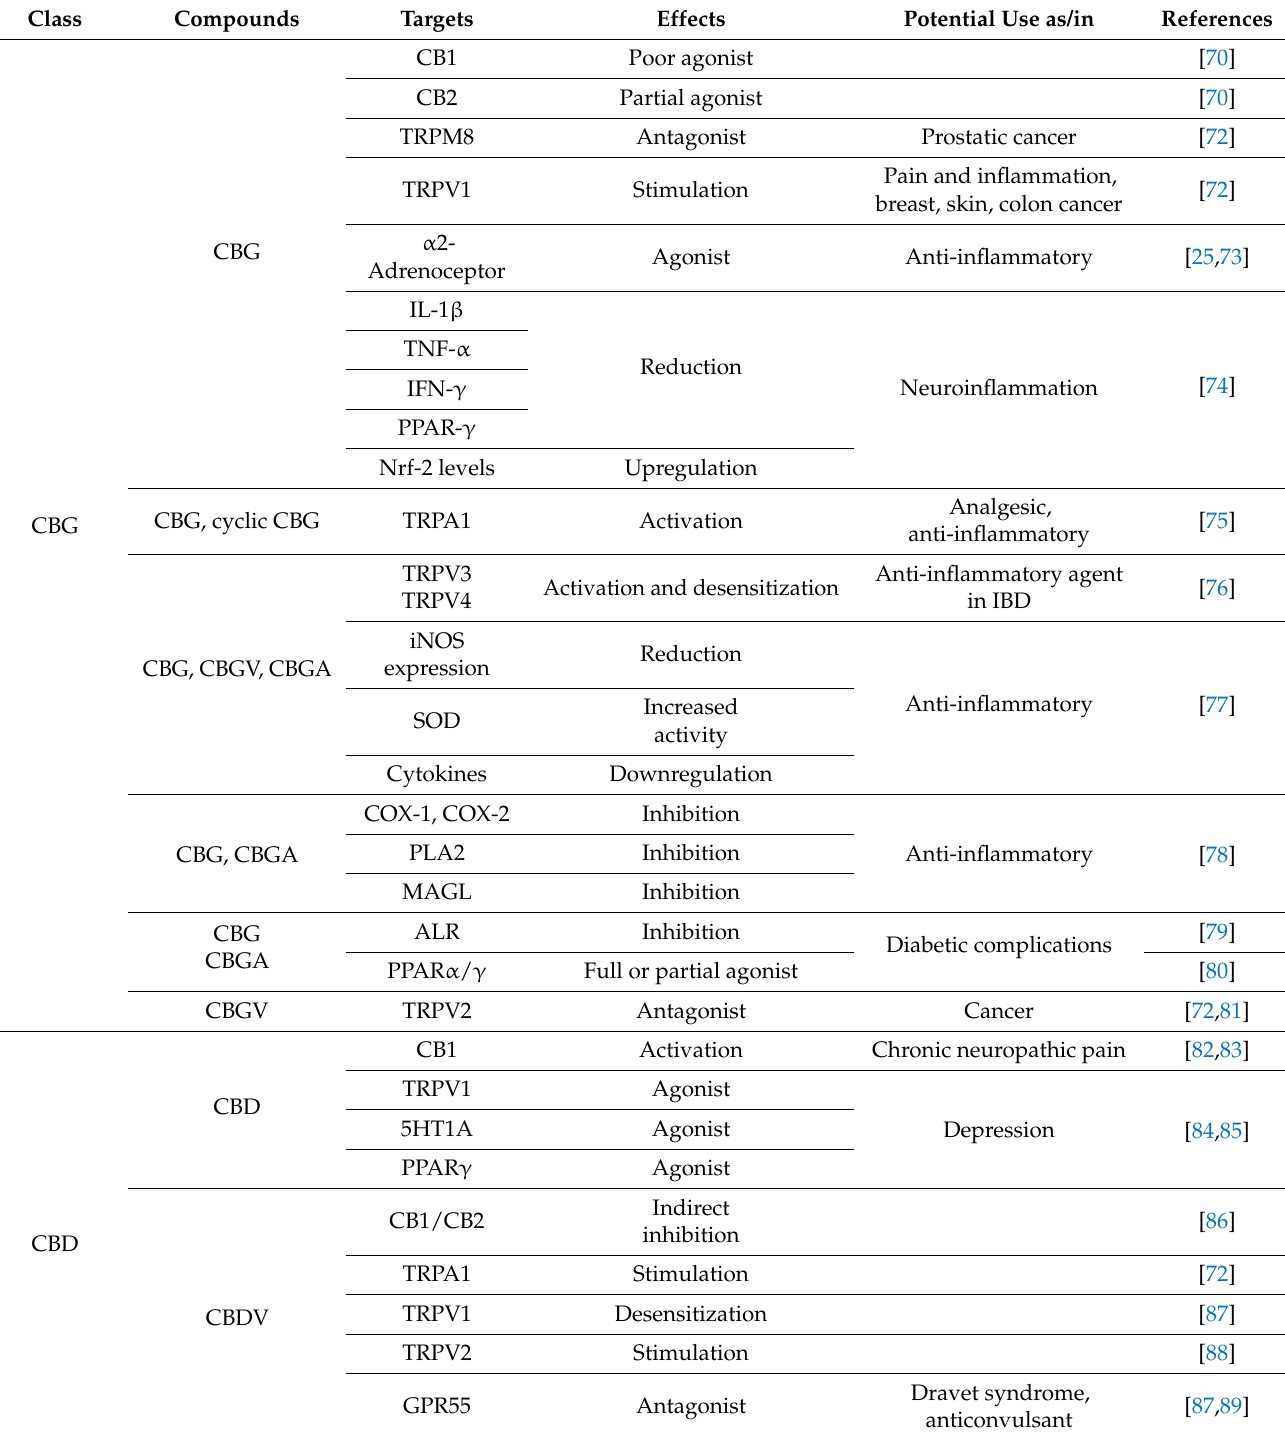
Table 2. Major cannabinoid